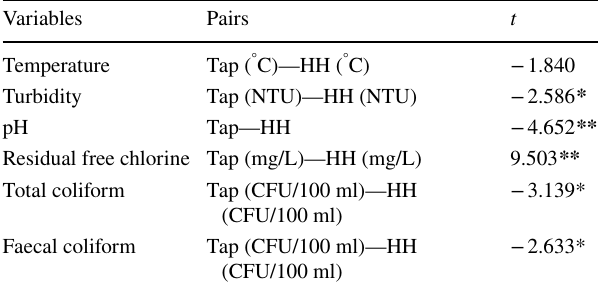
Table 2 Paired t test of physicochemical and bacteriological param- eters measured for the tap and household water samples, Hawassa, 2016